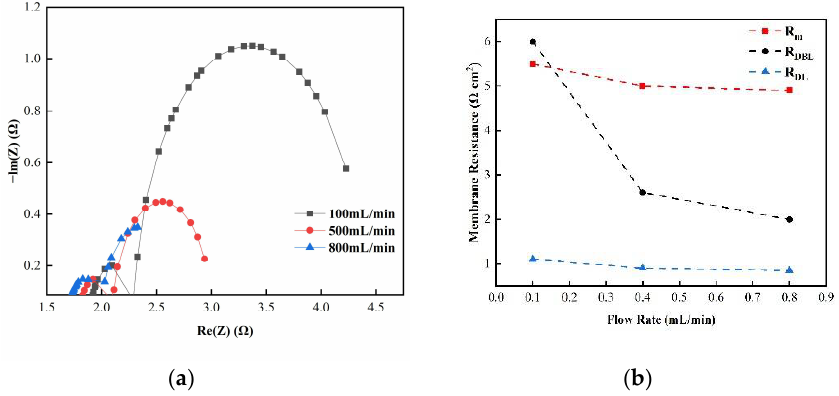
Figure 9. ( a ) The impedance of the Nyquist spectrum and ( b ) the membrane impedance R M , double layer impedance R DL , and diffusion layer impedance R DBL of the AEM membrane in 0.5 M NaCl solution.